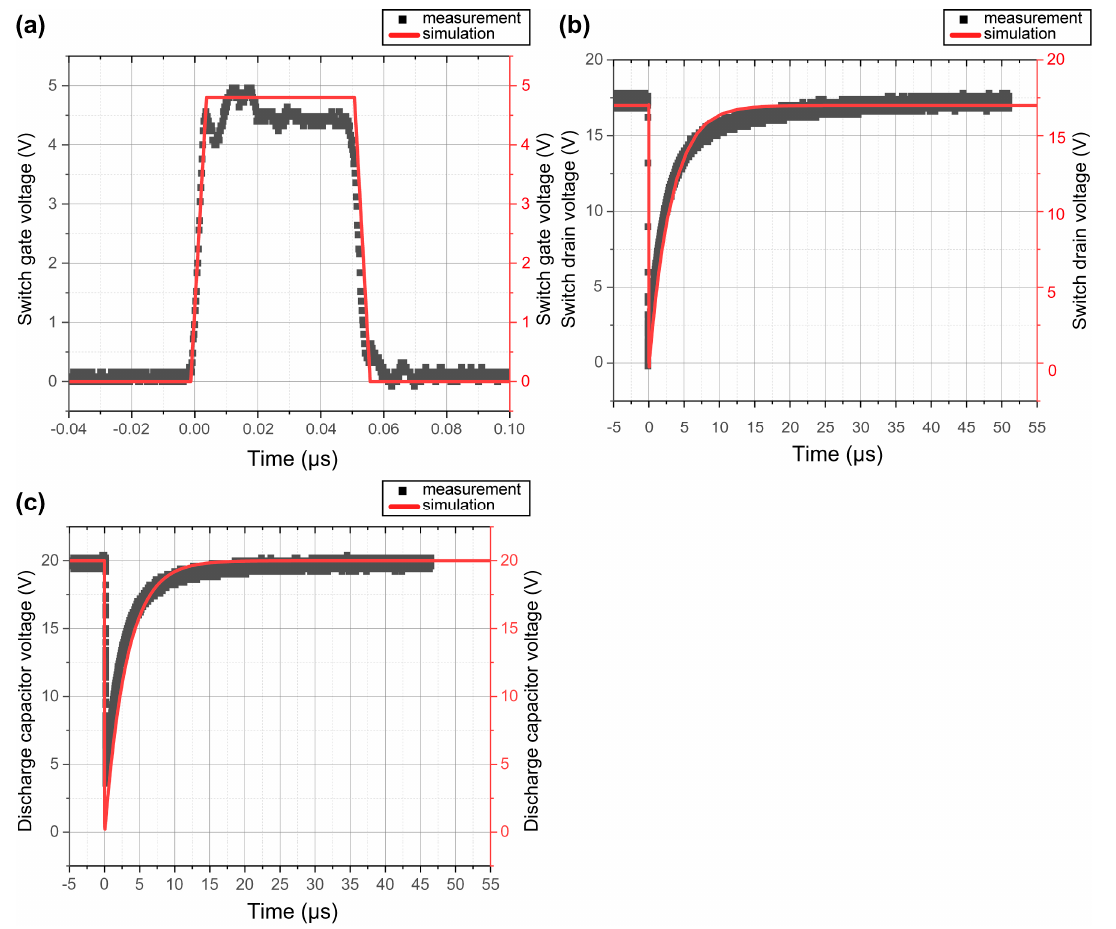
Figure 14. Comparison between measured and simulated waveforms of ( a ) switch − gate voltage; ( b ) switch − drain voltage; and ( c ) discharge − capacitor voltage.